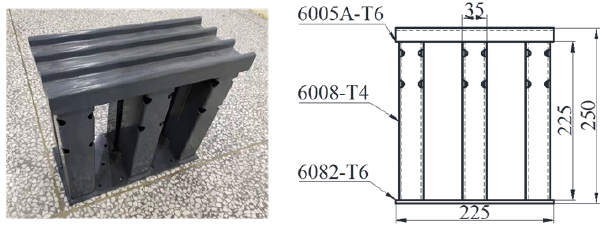
Figure 7. Site installation drawing of the specimen